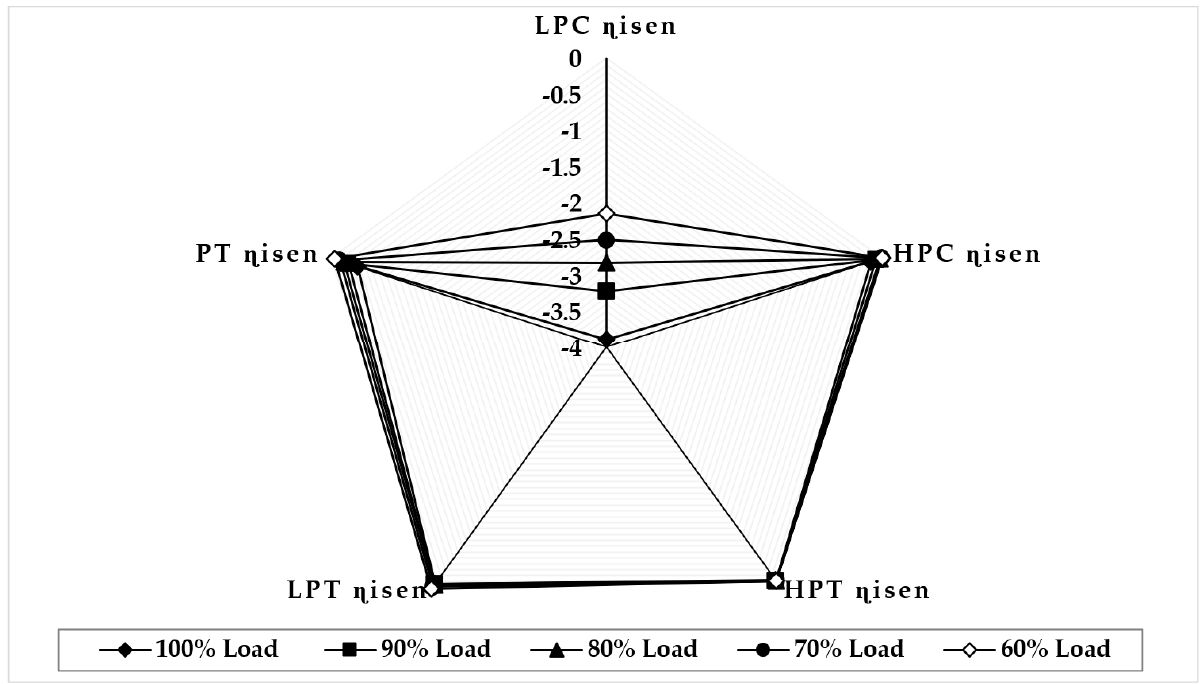
Figure 8. Deviation in component isentropic efficiency due to LPC erosion at 100% fault severity at full − load and part − load operation.